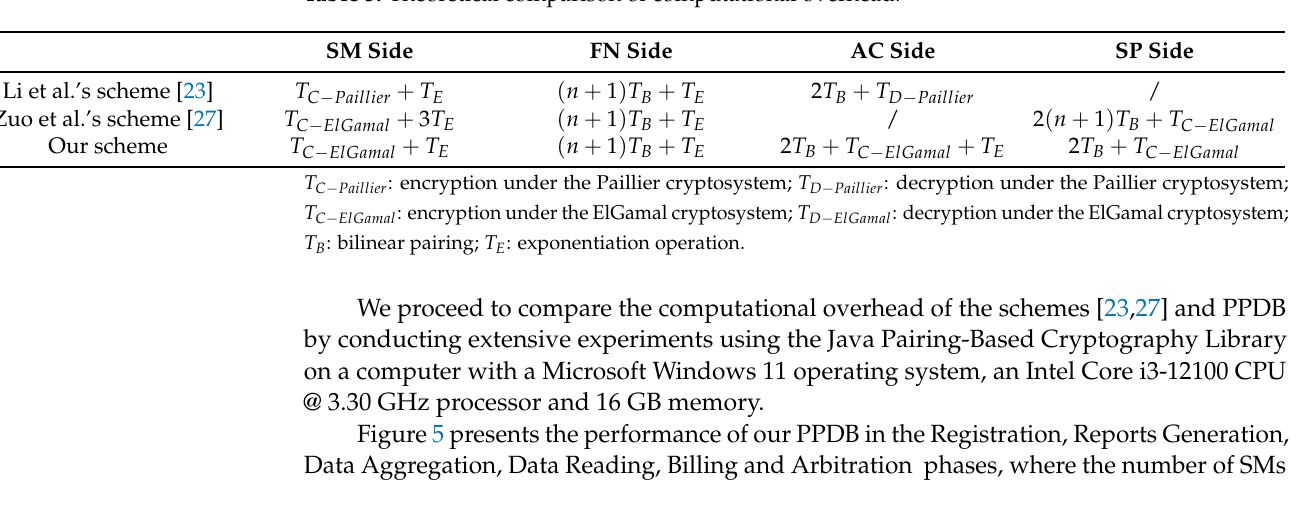
Table 3. Theoretical comparison of computational